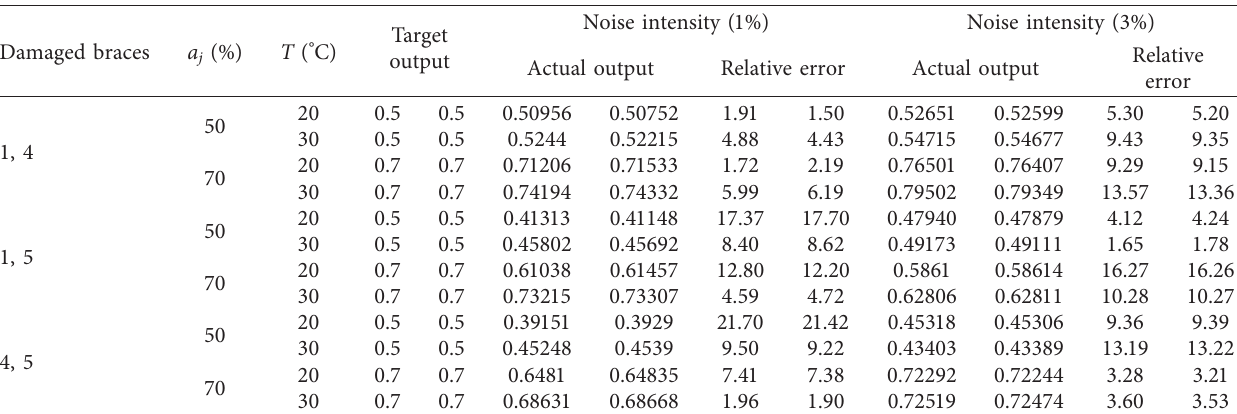
The target results of networks are shown in the parentheses. Table 11: The identification results of damage severities when two braces are damaged and contaminated with noises. Damaged